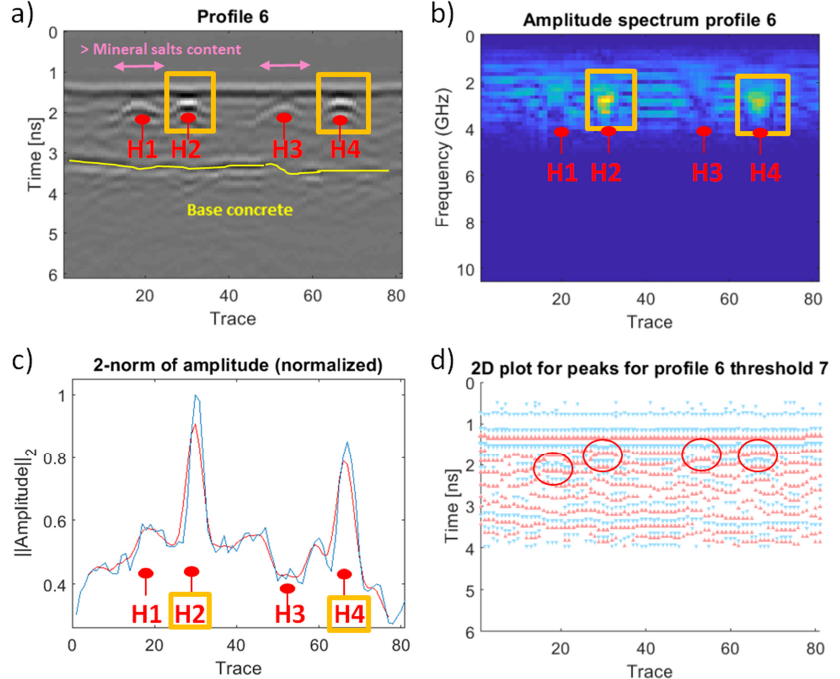
Figure 10. Graphics obtained for GPR profile 6 and interpretation. The orange rectangles in ( a ), ( b ) and ( c ) indicate open-air rebars while pink arrows are associated to zones with high salt concentration. The red circles in ( d ) represent a positive polarity of the reflections produced by the rebars. Table 3. Amplitude (A) values and travel-time distances (twt) measured on the traces where the main focuses of the hyperbolas were registered. The numbering of the hyperbolic reflections (H) and the colors are in concordance with those in Figures 5 to 10.